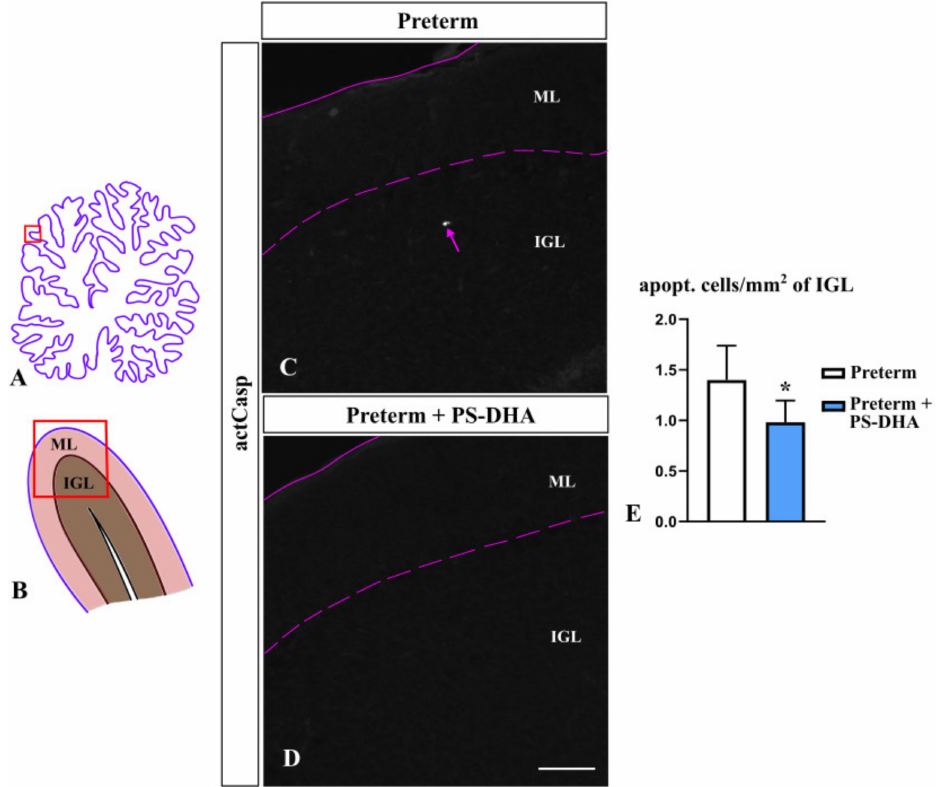
Figure 3. Decreased apoptosis in the IGL (internal granule cell layer) of preterm pigs that received PS-DHA. ( A , B ) Schematic of midsagittal section of the newborn pig cerebellum ( A ). Panel B shows a higher magnification of the region boxed in panel A. ML, molecular layer, IGL, internal granule cell layer. Panels C and D display sections immunostained against activated Caspase 3, photographed under 10 × magnification, which correspond to the region shown by the box in panel B. ( C – E ) The number of apoptotic cells (act Casp + cells, pointed by pink arrow in panel C) was lower in the IGL of preterm pigs that received PS-DHA relative to control preterm pigs ( E ). n = 5 pigs per group, * p < 0.05. Pink solid and dashed lines show the outer cerebellar surface and the molecular layer (ML) / IGL boundary, respectively. Scale bar: 100 µ